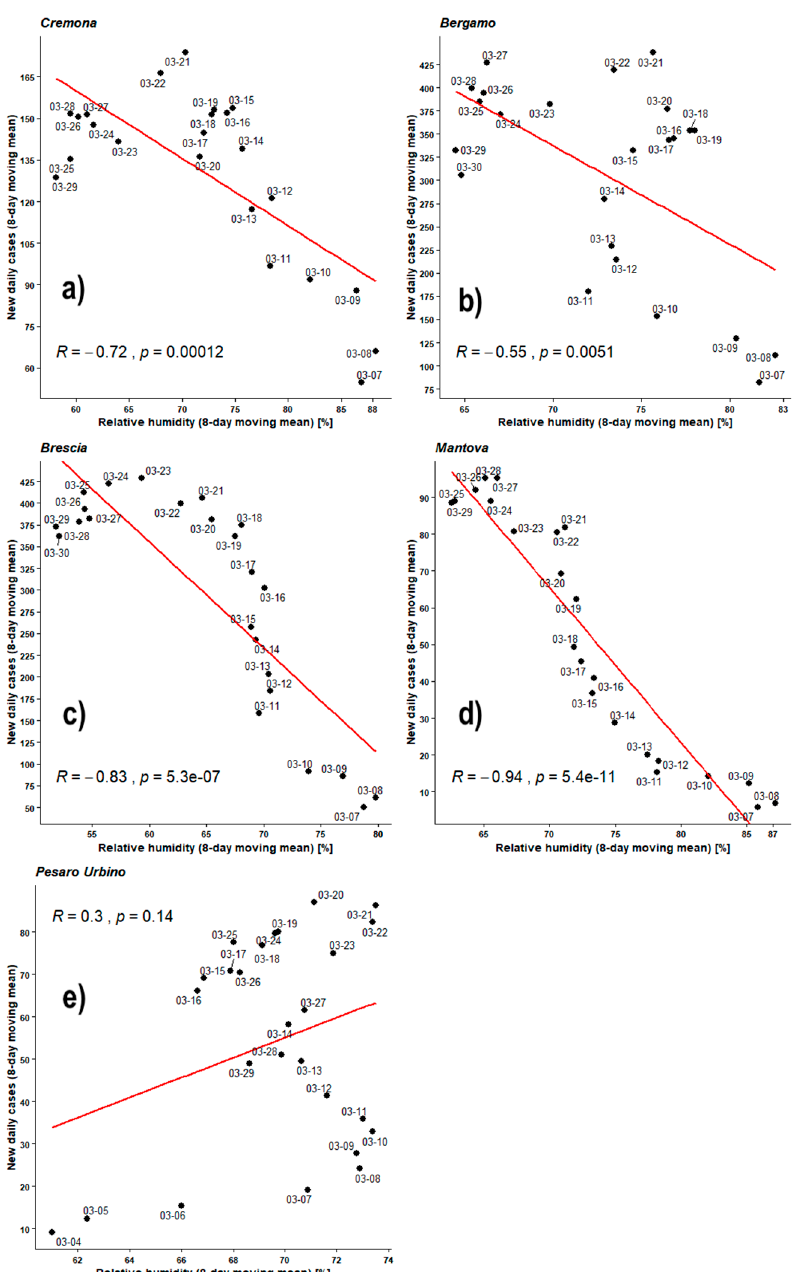
Figure 10. Scatter plot and linear regression for the 8-day moving means of new daily cases of COVID-19 against relative humidity for five Italian provinces: ( a ) Cremona, ( b ) Bergamo, ( c ) Brescia, ( d ) Mantova, ( e ) Pesaro Urbino. Labels report, in MM-DD format, the last day of the moving means. Pearson correlation coefficient is reported as ‘R’ while probability value is reported as ’ p ’.